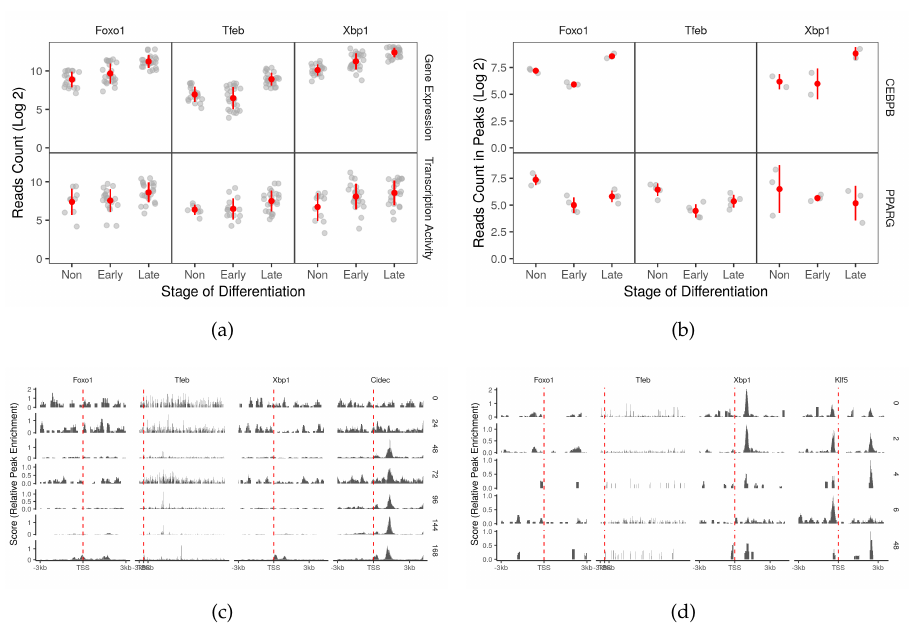
Figure 5. Autophagy transcription factor gene targets of the adipogenic transcription factors. ( a ) The reads count of three autophagy transcription factor coding genes in RNA-Seq samples (n = 66) were used to represent the gene expression. The reads count in peaks of POLR2A in genomic region of three autophagy transcription factor coding genes from ChIP-Seq samples (n = 12) was used to represent the transcription activity. ( b ) The reads count in peaks of CEBPB and PPARG ChIP-Seq samples was used to represent peak enrichment. The Peaks from the ( c ) PPARG and ( d ) CEBPB ChIP-Seq samples were visualized by the time point and position around the transcription start site ( ± 3 kb). Cidec and klf5 were used as positive control